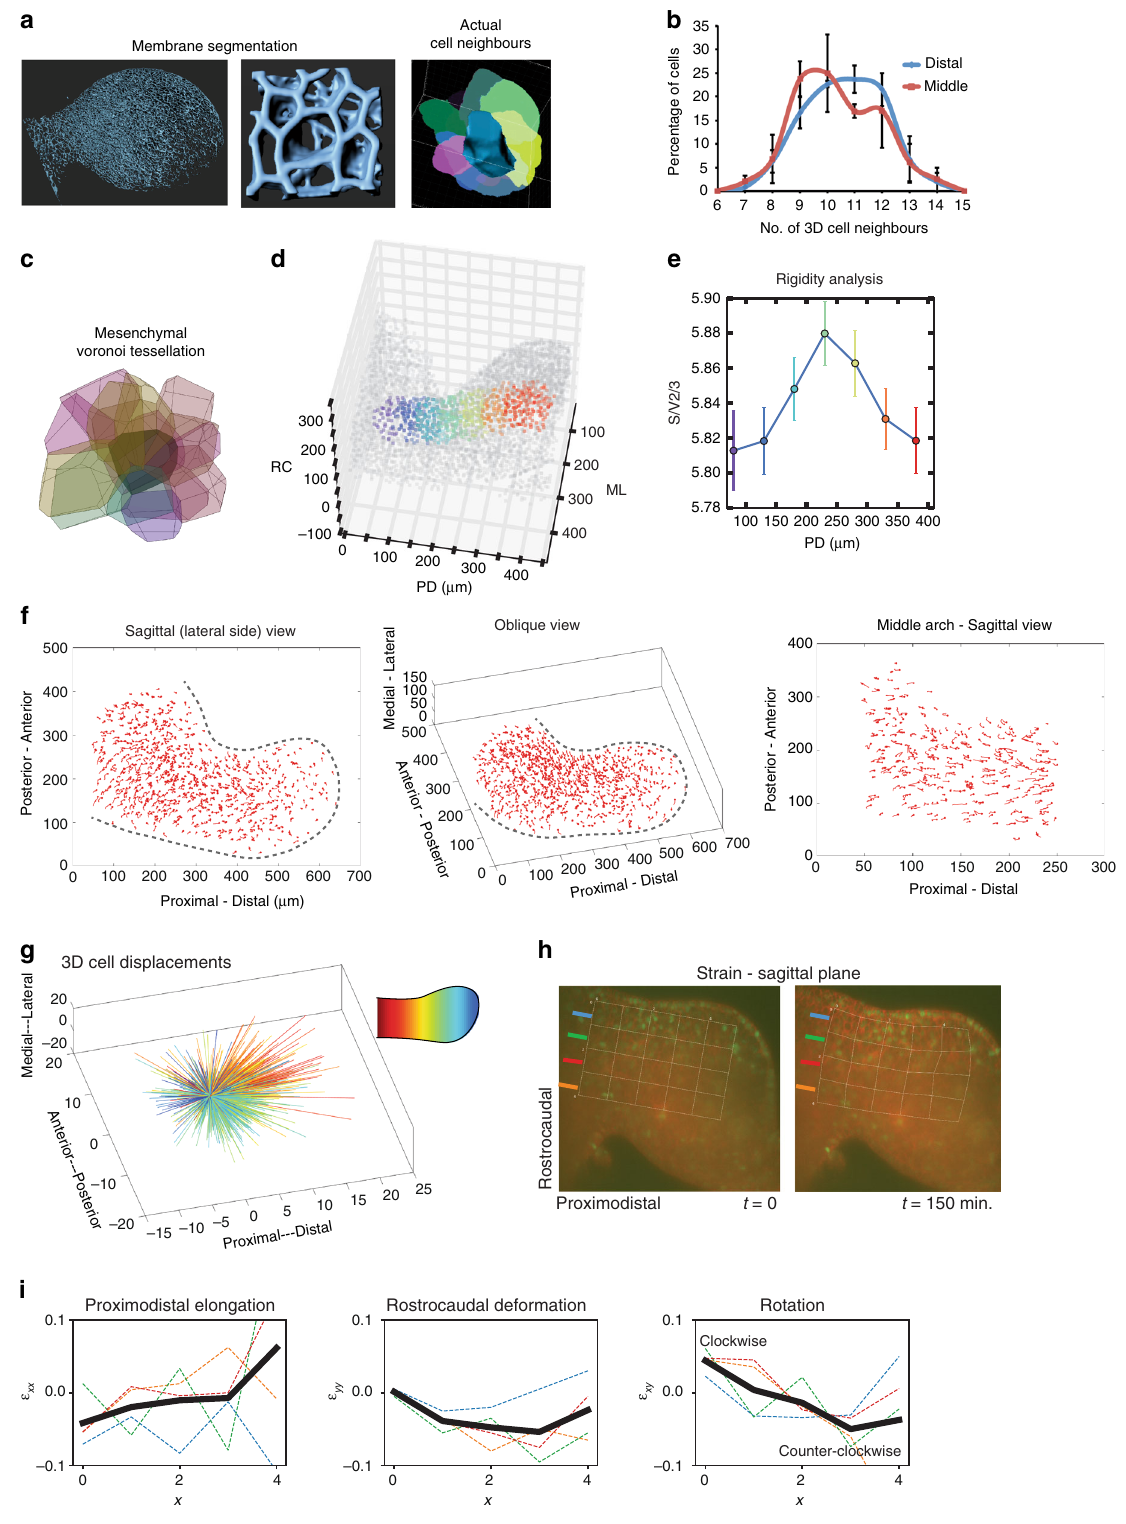
Cortical forces correlate with mesenchymal intercalations . Cortical tension is a key parameter that regulates cell sorting and intercalation during development 55,56 . Local actomyosin abun- dance or cell interface length changes have been used to estimate relative cortical tension, but may not re fl ect actual forces or their dynamic fl uctuations. A more direct proxy for cortical tension would be force experienced by the cortical protein vinculin,